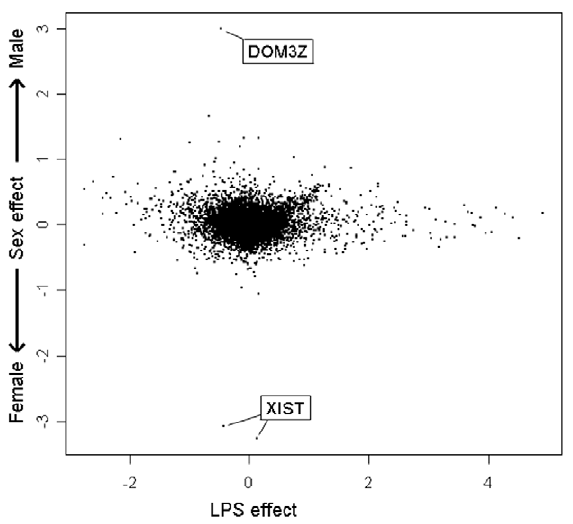
Figure 5. Effect of LPS and sex on gene expression with log2 ratios contributed by each component along the x and y axes respectively.